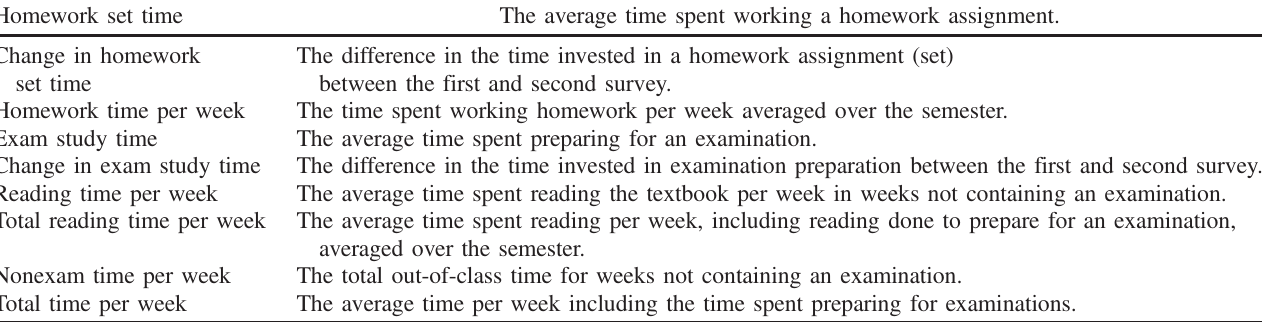
TABLE I. Summary of time-on-task variables. Homework set time The average time spent working a homework assignment. Change in homework The difference in the time invested in a homework assignment set time